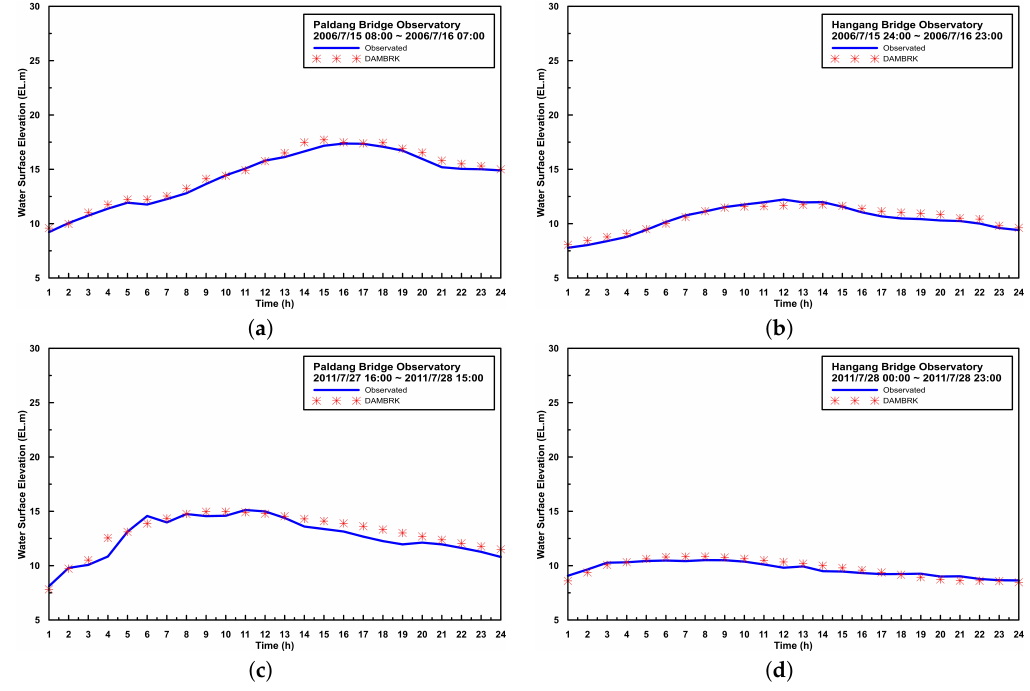
Figure 4. Validation of DAMBRK with observed W.S.E. ( a ) W.S.E. in Paldang Bridge (2006); ( b ) W.S.E. in Hangang Bridge (2006); ( c ) W.S.E. in Paldang Bridge (2011); ( d ) W.S.E. in Hangang Bridge (2011).